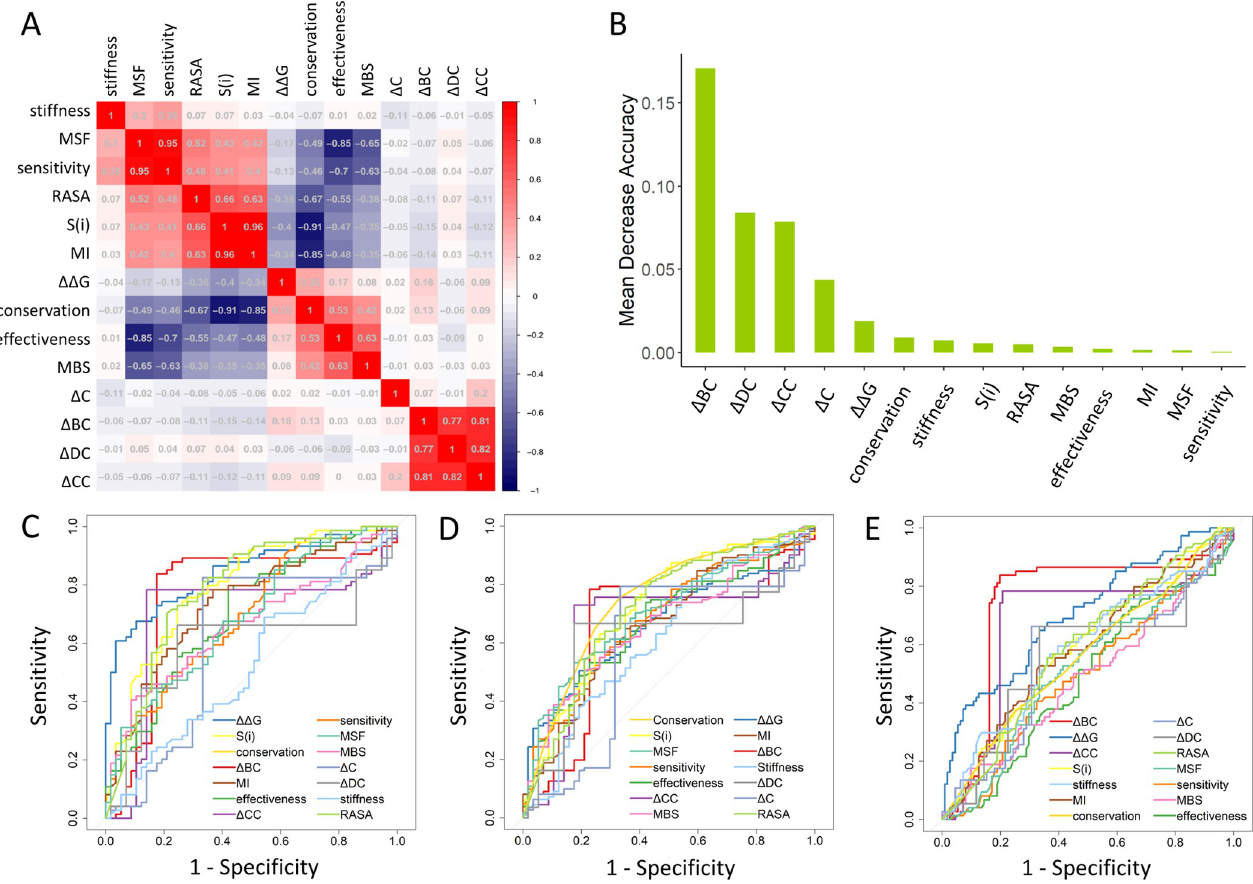
Fig 10. Performance evaluation of feature classification. (A) Heatmap of pairwise Spearman’s rank correlation coefficients between different features. (B) Feature importance of all used features ranked based on mean decrease accuracy in the RF classification. ROC curve AUCs for 14 features as a function of 1-specificity, including ROC curves for evaluating each feature in classifying ALPL mutations between (C) the control and severe groups, (D) control and mild groups, and (E) mild and severe groups.